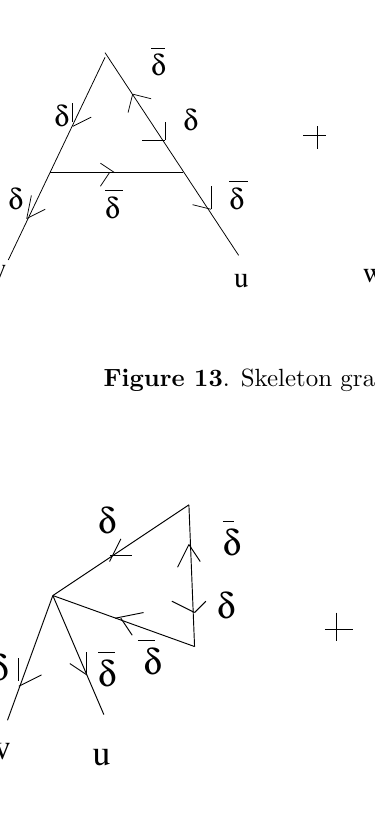
Figure 14 . Skeleton graphs for (cid:8) 12 ;D